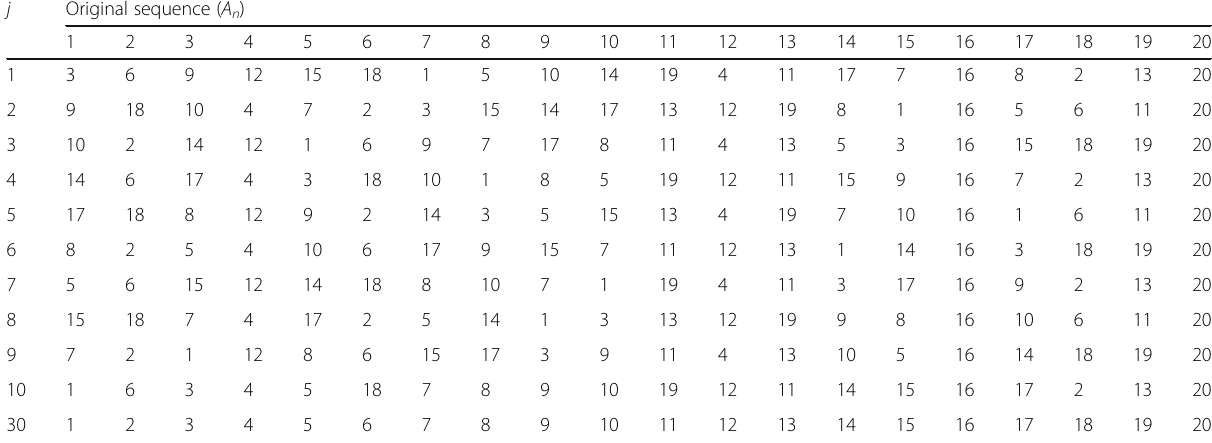
Table 2 Each Josephus cycle state of experiment 2 j Original sequence ( A n